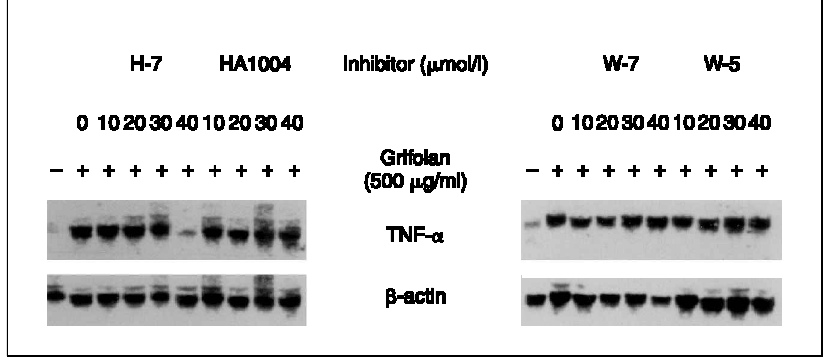
Fig. 1. Effect of signal transduction inhibitors on tumor necrosis factor (TNF)- a messen- ger RNA. Expression was induced with grifolan. RAW264.7 cells were stimulated with grifolan (500 m g/ml) with and without inhibitors for 6 h at 37 ° C.